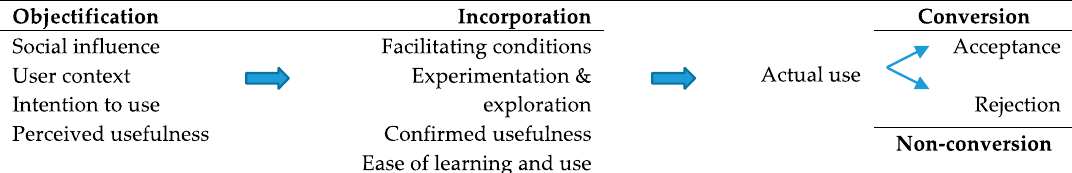
Figure 2. The main variables of the Senior technology acceptance and adoption model (STAM), adapted after [27].